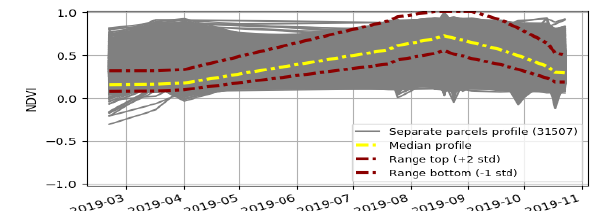
Figure 2. NDVI profiles of Cotton (CTN) parcels for the 35TLF Sentinel-2 tile. The accepted parcels within standard deviation (std) range, above and below the median curve, were 13341 out of 31507.